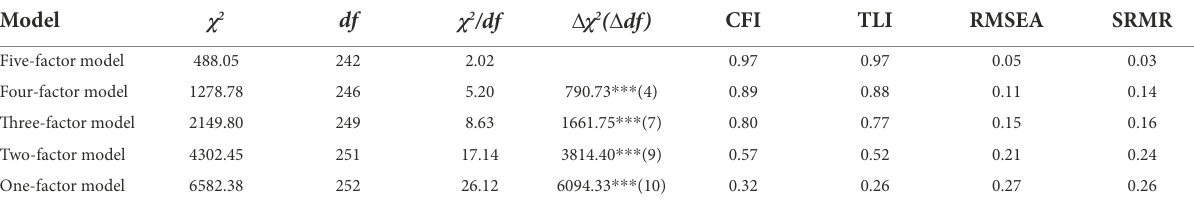
TABLE 1 Results of confirmatory factor analysis.